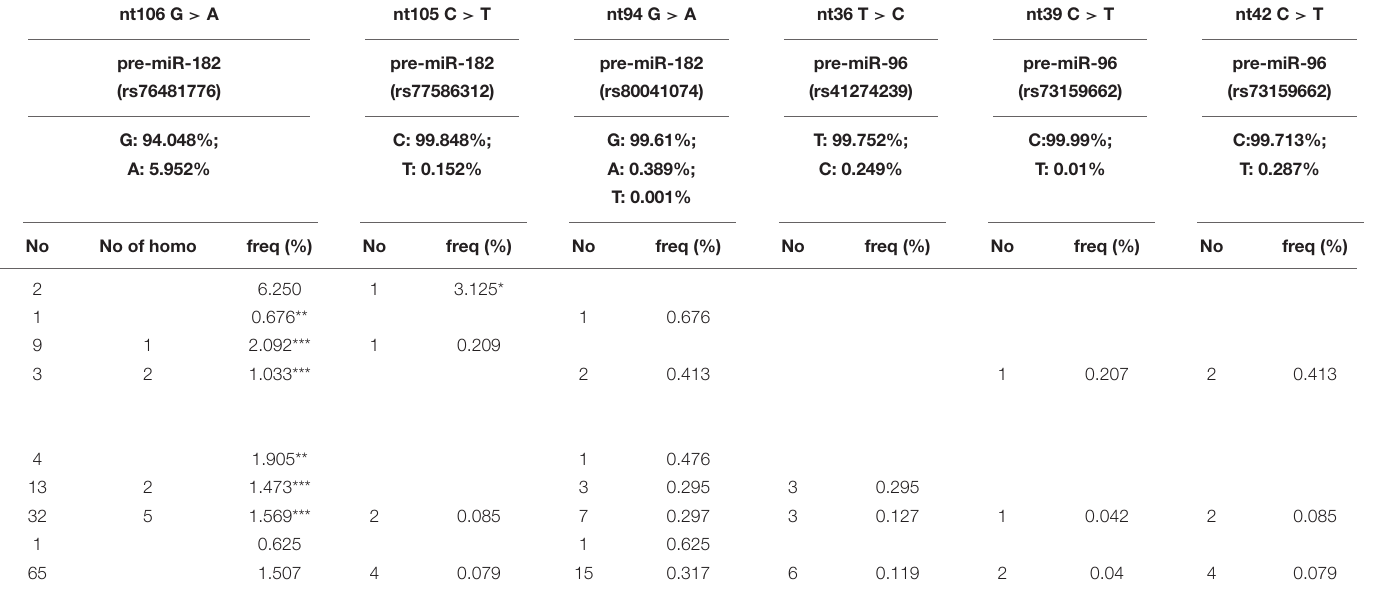
TABLE 2 | Allele frequency of the sequence variants among the samples. Disease